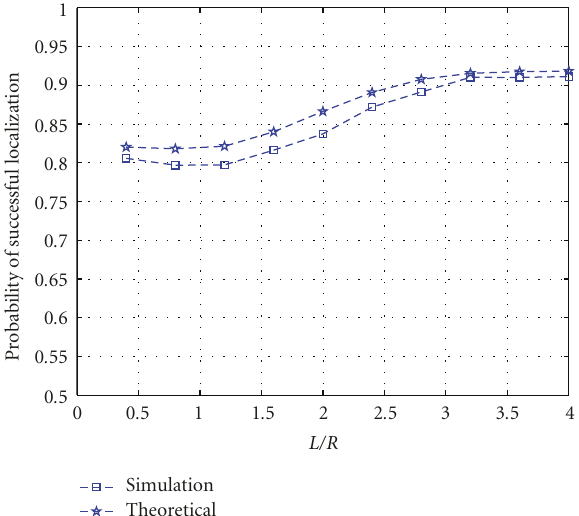
Figure 8: Probability of successfully identifying all attacked loca- tors: simulation versus theoretical.